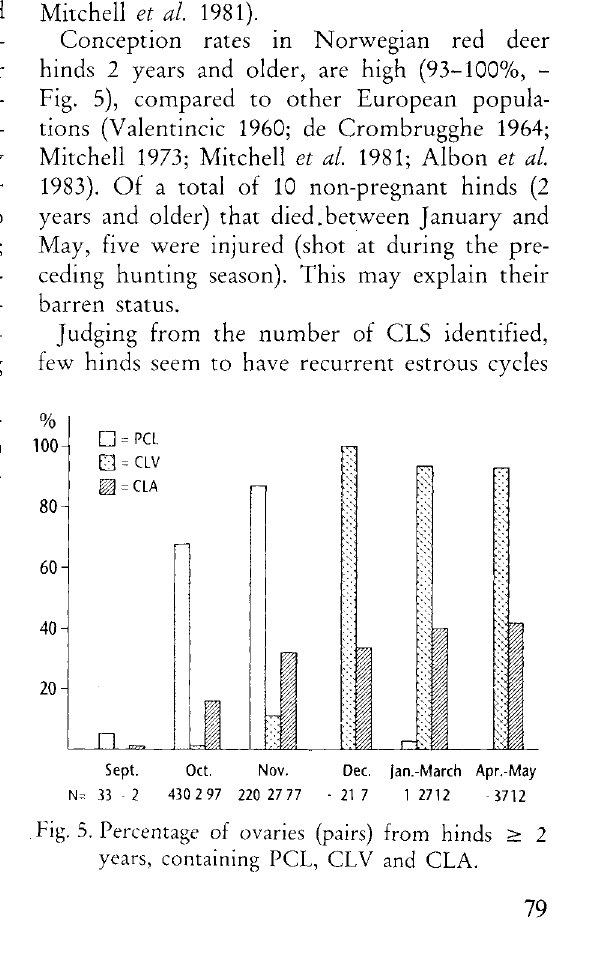
Fig. 5. Percentage of ovaries (pairs) from hinds > 2 years, containing P C L, C LV and C L